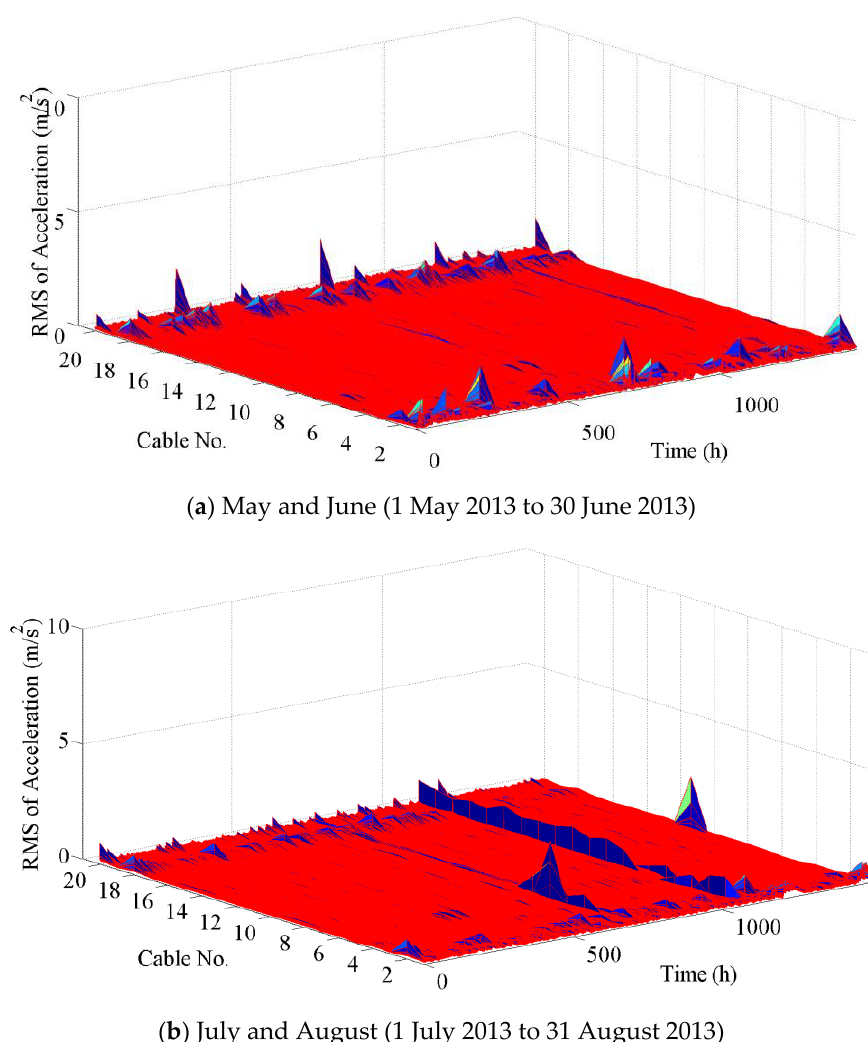
Figure 4. Vibration response of stay cables of the stayed-cable bridge (10 min mean) in 2013.